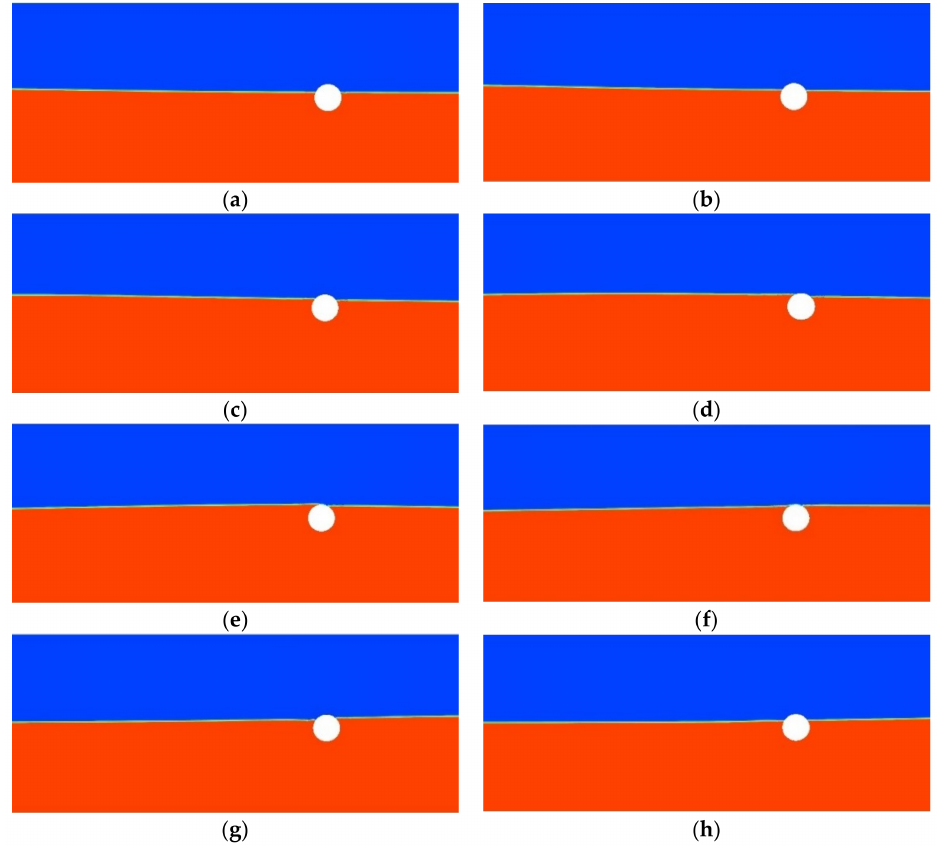
Figure 24. Snapshot of evolution process of a solitary wave interacting with the unmoved cylinder for model 2; ( a ) t = 17 s, ( b ) t = 17.5 s, ( c ) t = 18 s, ( d ) t = 18.5 s, ( e ) t = 19 s, ( f ) t = 19.5 s, ( g ) t = 20 s, ( h ) t = 20.5 s.